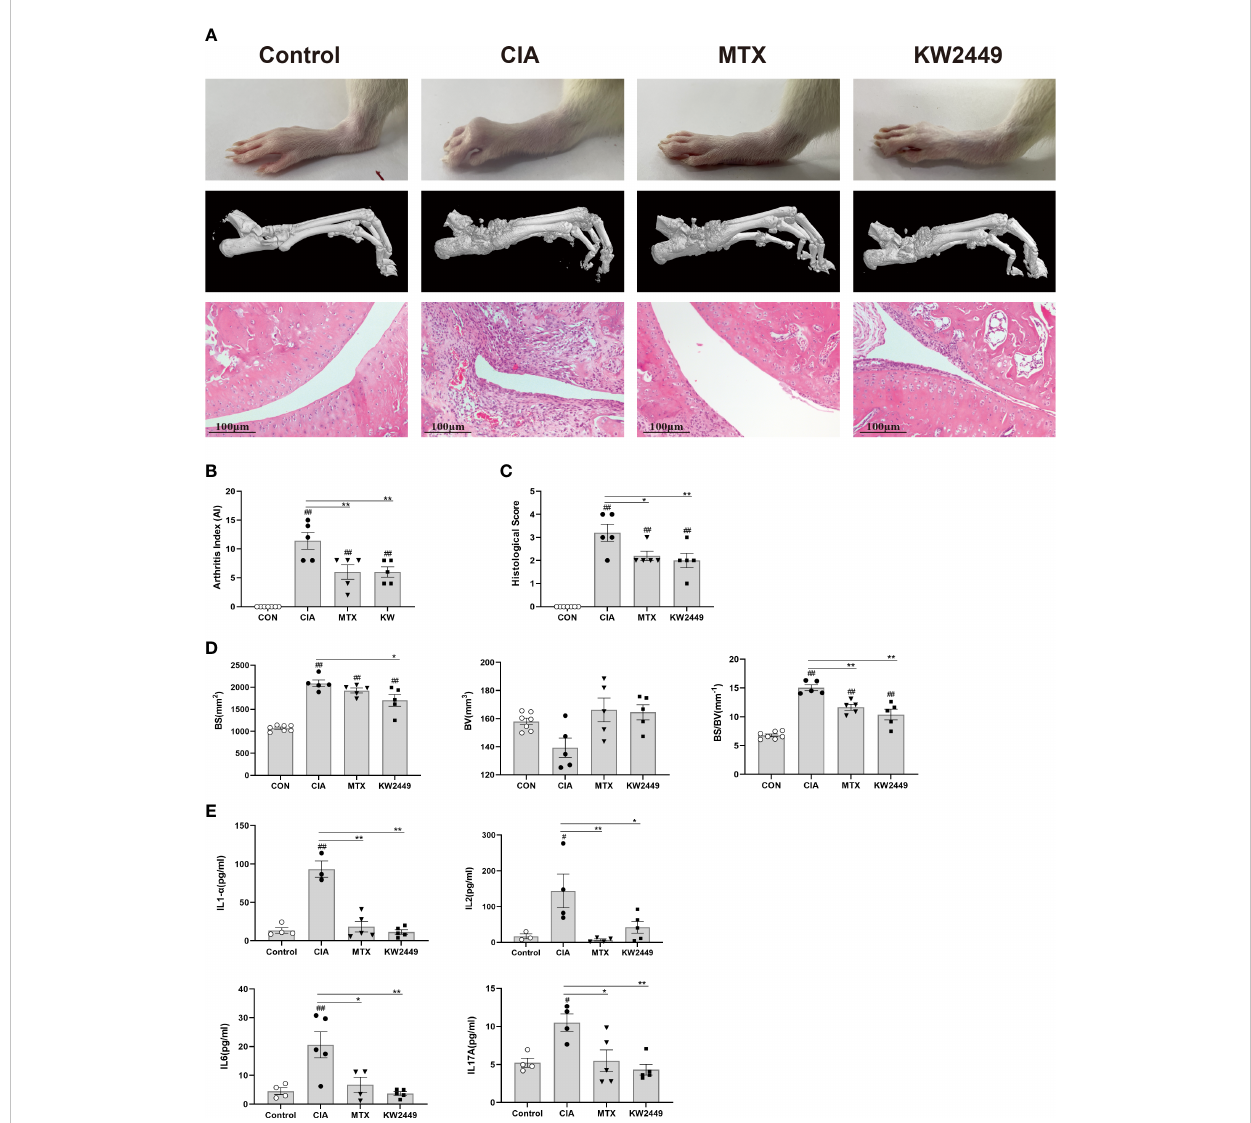
FIGURE 1 KW2449 reduced in fl ammation, joint tissue damage and joint bone destruction in CIA rats. (A) Representative ankle images, micro-CT images of ankle joints and HE-stained ankle tissue images of each group. Original magni fi cation: 100×, scale bars = 100 m m. (B) Arthritis index (AI) scores of each group after treatment. (C) Histological score of each group. (D) The bone surface area (BS), bone volume (BV), and BS/BV values of ankle joints in each group. E Plasma levels of in fl ammatory cytokines IL-17A, IL-1 a , IL-2 and IL-6 in each group. Means ± SEs, n=5, # P < 0.05, ## P < 0.01, vs. control, * P < 0.05, ** P < 0.01, vs.